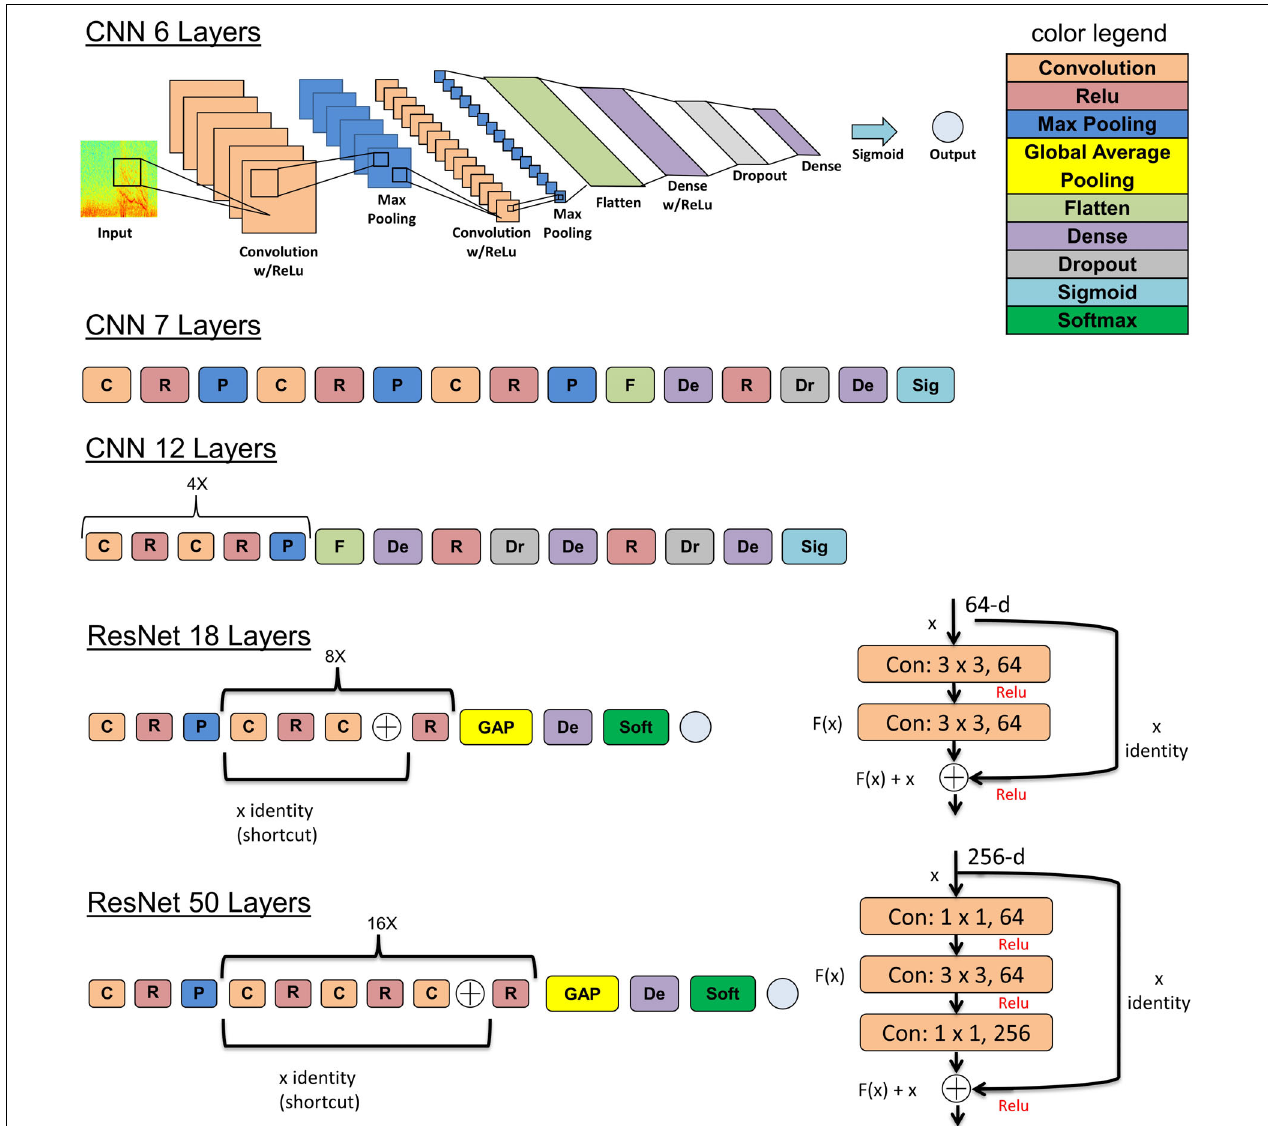
FIGURE 5 | The 5 model architectures used in this study. 6, 7, and 12 layer convolutional neural networks (CNN) models were trained and tested in this study along with 18 and 50 layer ResNet models. Inspiration for the CNN model architectures was derived from a wide range of sources including https://tinyurl.com/y76stqkc, while the ResNet model architectures are available on the Keras webpage: